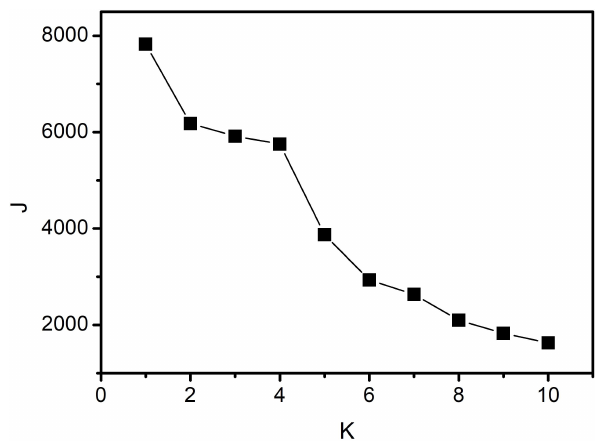
Figure 9: Clustering validity analysis for fiber bundle tensile test